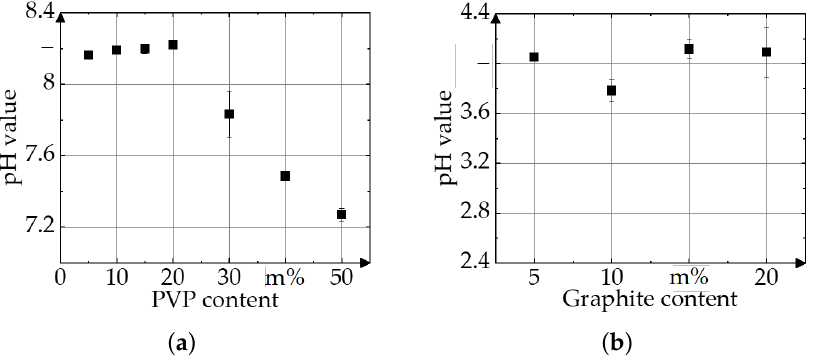
Figure 5. PH value as a function of ( a ) PVP content for a solution without nanoparticles (see Table A7) and ( b ) graphite content for aqueous dispersions containing 20 m% PVP (see Table A8).